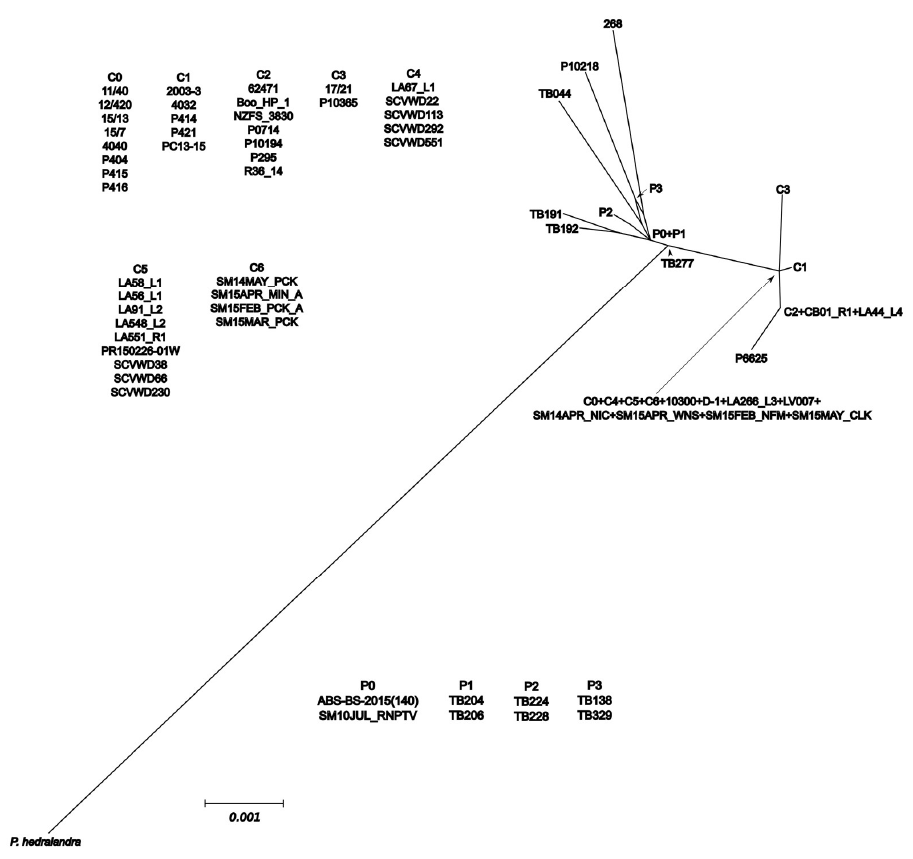
Figure 5. Split-decomposition network from mitochondrial cox2+cox1 loci of Phytophthora cactorum and P. pseudotsugae . Accession information listed in Table S1. Figure created with SplitsTree4 and annotated with InkScape. Scale bar is split support for node connections.